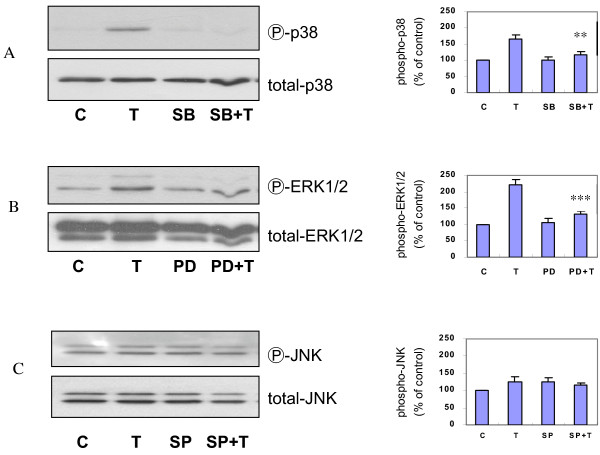
Effects of MAPKs inhibitors on TGF-β1 induced activation of MAPKs. Confluent and growth-arrested ASMCs were pretreated for 1 hour with SB 203580, PD 98059, or SP 600125, prior to 24-hour treatment with 1 ng/ml of TGF-β1 (T), followed by protein extraction and Western analysis for phosphorylated or total p38 (Panel A), ERK1/2 (Panel B), and JNK (Panel C). The blots are representatives of 3 independent experiments. C = control. ** p < 0.01 *** p < 0.001 compared to T.